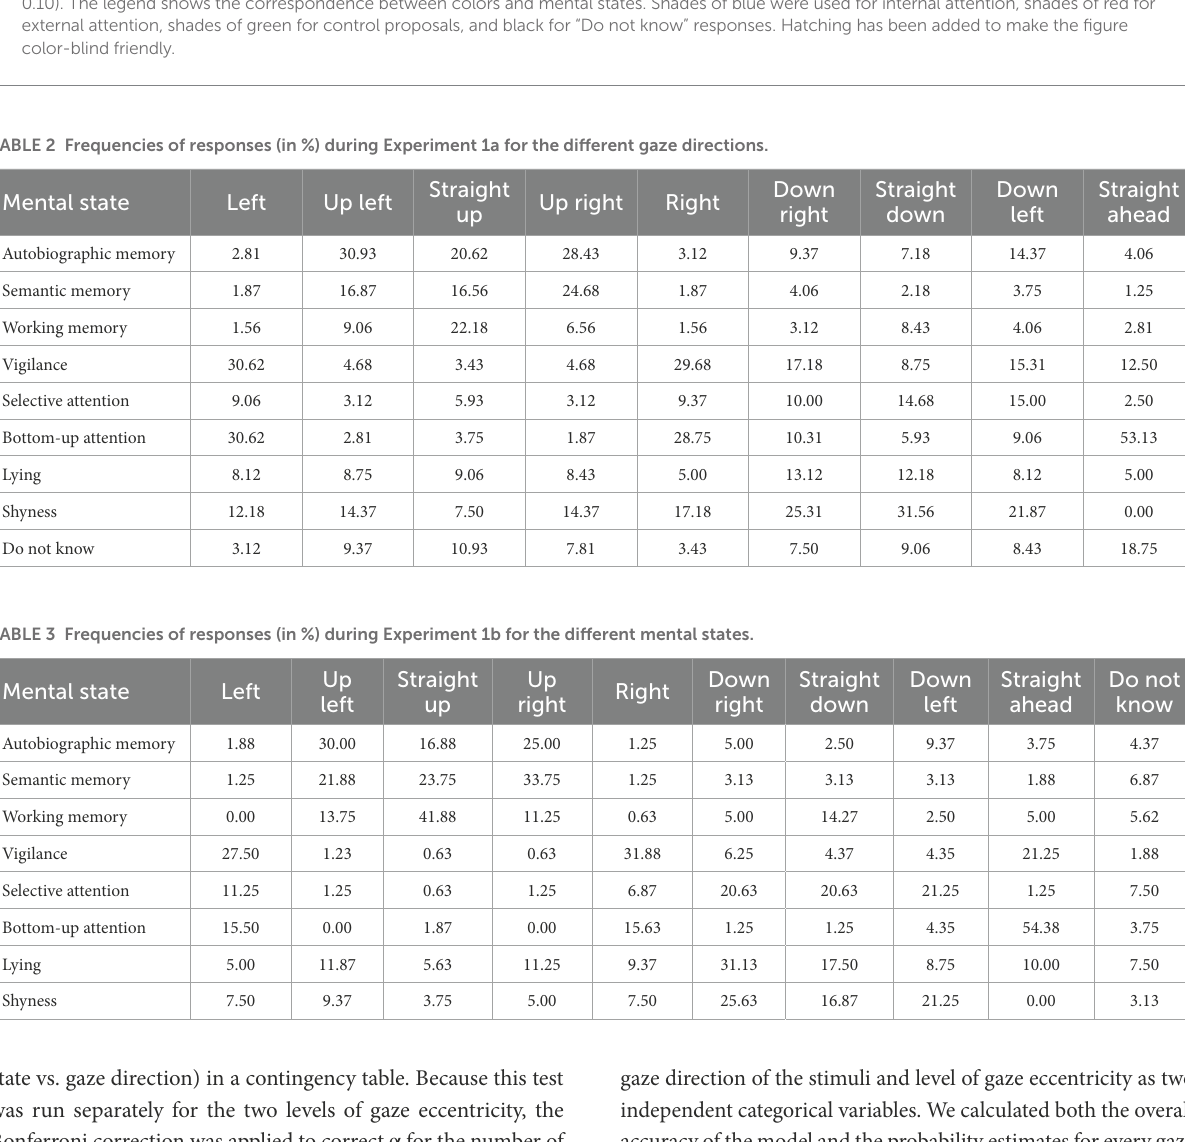
Straight Up right Right up